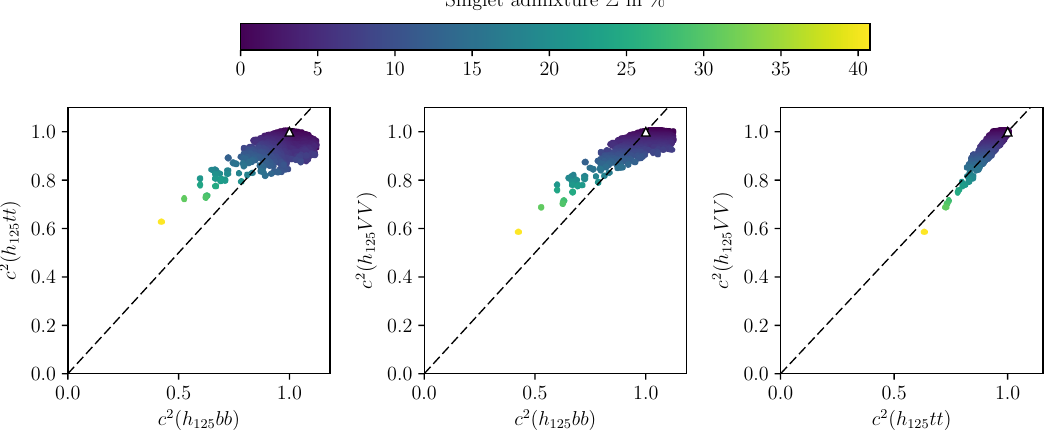
Figure 7 . NMSSM: singlet admixture (cid:6) NMSSM of the h 125 as a function of the e(cid:11)ective couplings squared. The white triangle denotes the SM value. The dashed lines represent equal scaling of the